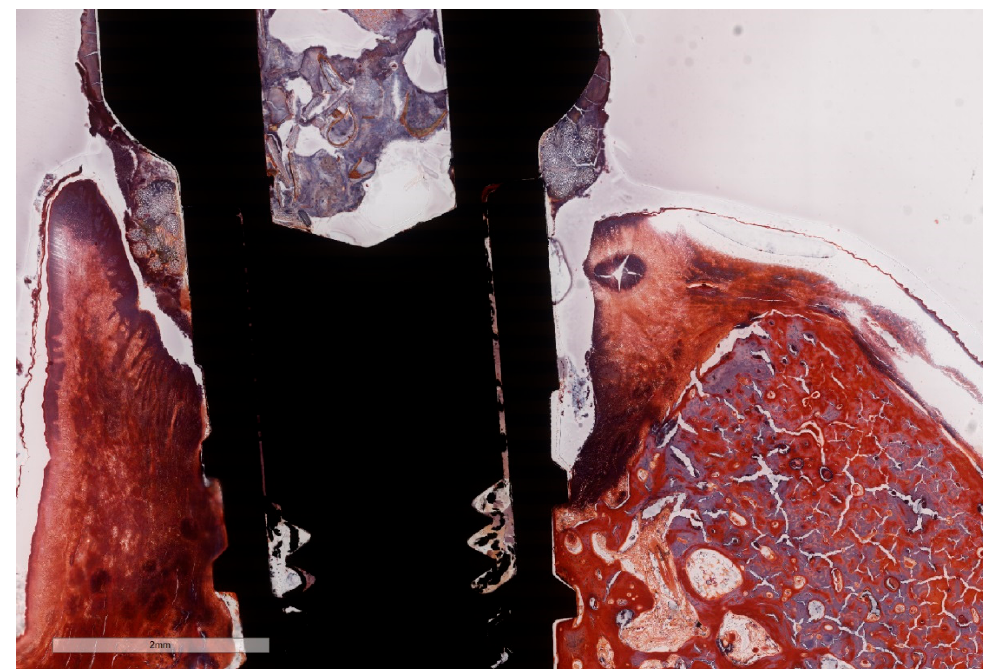
Figure 12. Position and effect of the ligatures. Note the intense inflammation on the left (buccal) aspect and the accentuate resorption of the buccal plate, up to its total loss. In the oral aspect, the peri-implant sulcus is deep and wide and the implant is in intimate contact with the ICT in just a limited area above the BD (implant #1, MGA, bar measure is 2 mm).